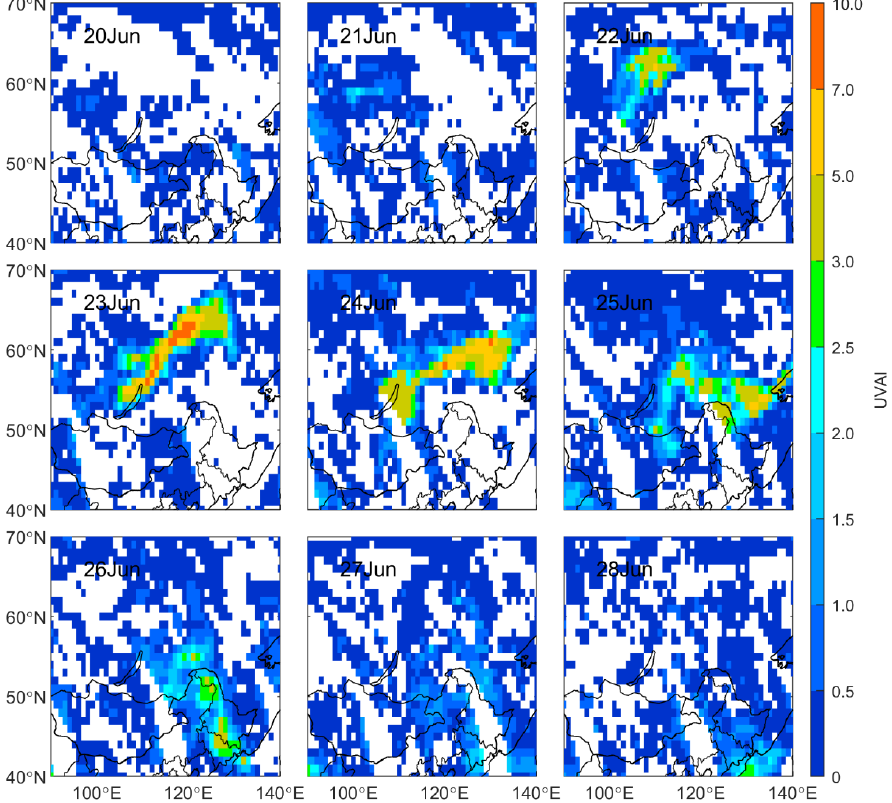
Figure 8. Spatial distribution of OMI UVAI from 20 June to 28 June 2017 in Northeast Asia.